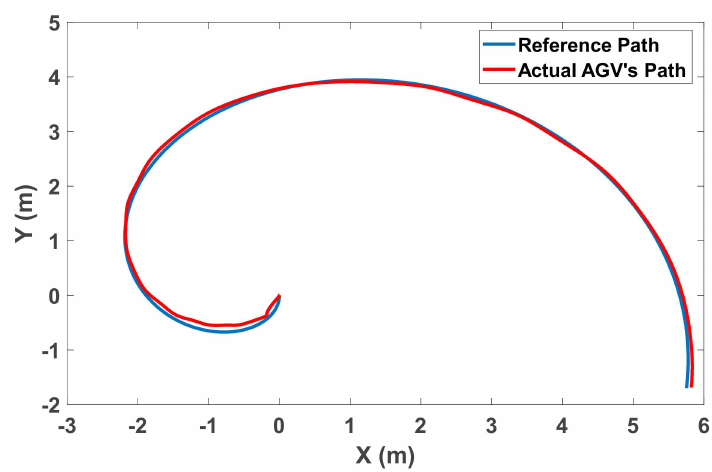
Figure 8. The path-tracking performance of AGV for spiral